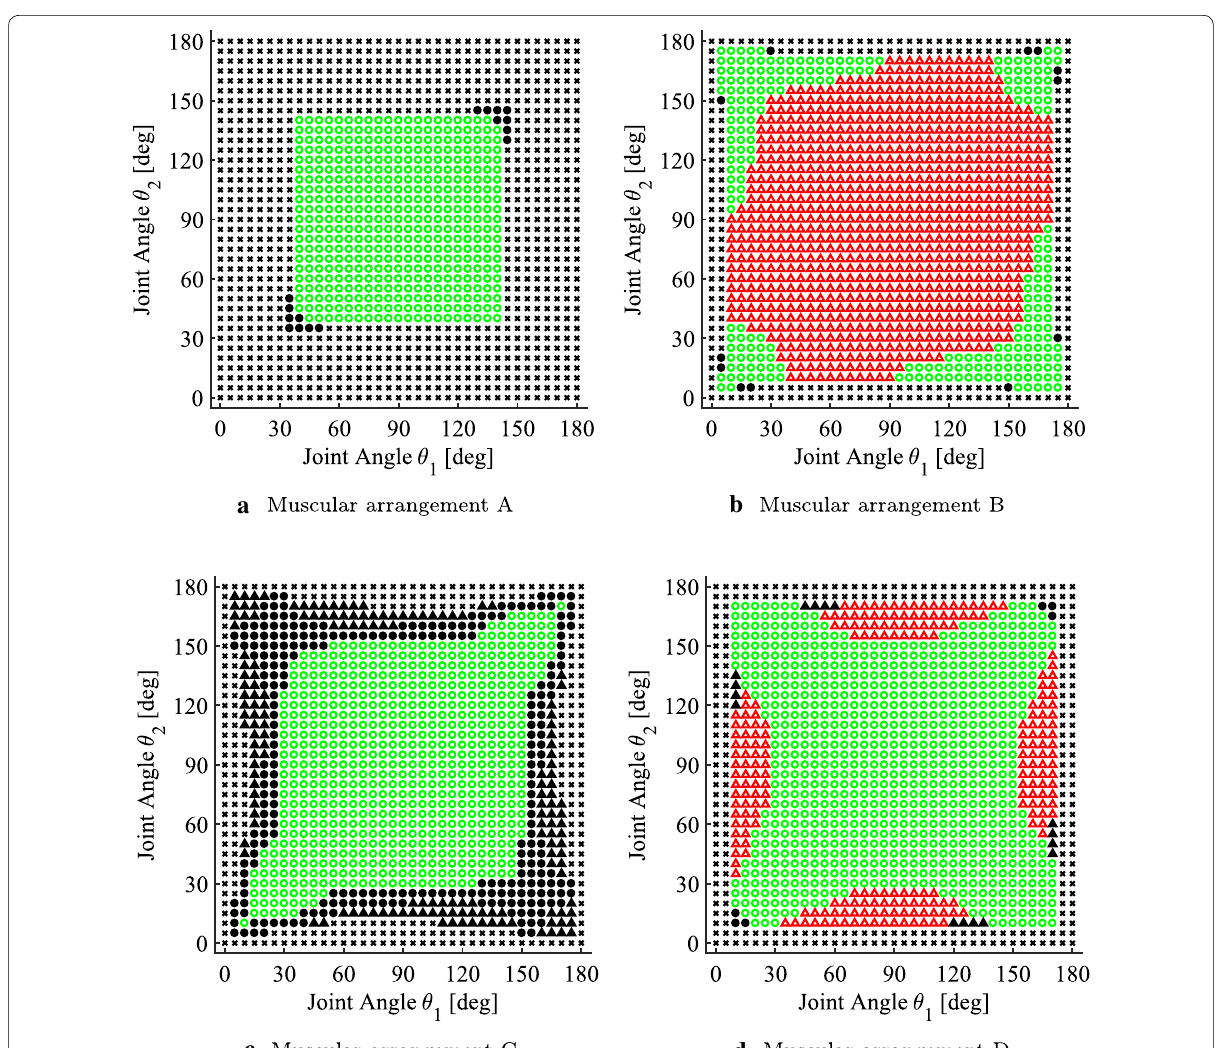
Fig. 10 Minimality discrimination of the shapes of the potential at each desired posture (green circular markers indicates a local minimized potential at the posture. Red triangular markers indicates a non-minimized potential at the posture. Black circular markers indicates a local minimized potential, however, negative tensile forces are generated on the muscles. Black triangular markers indicates a non-minimized potential, and, negative tensile forces are generated on the muscles. indicates that “ Vector Closure ” is not ×